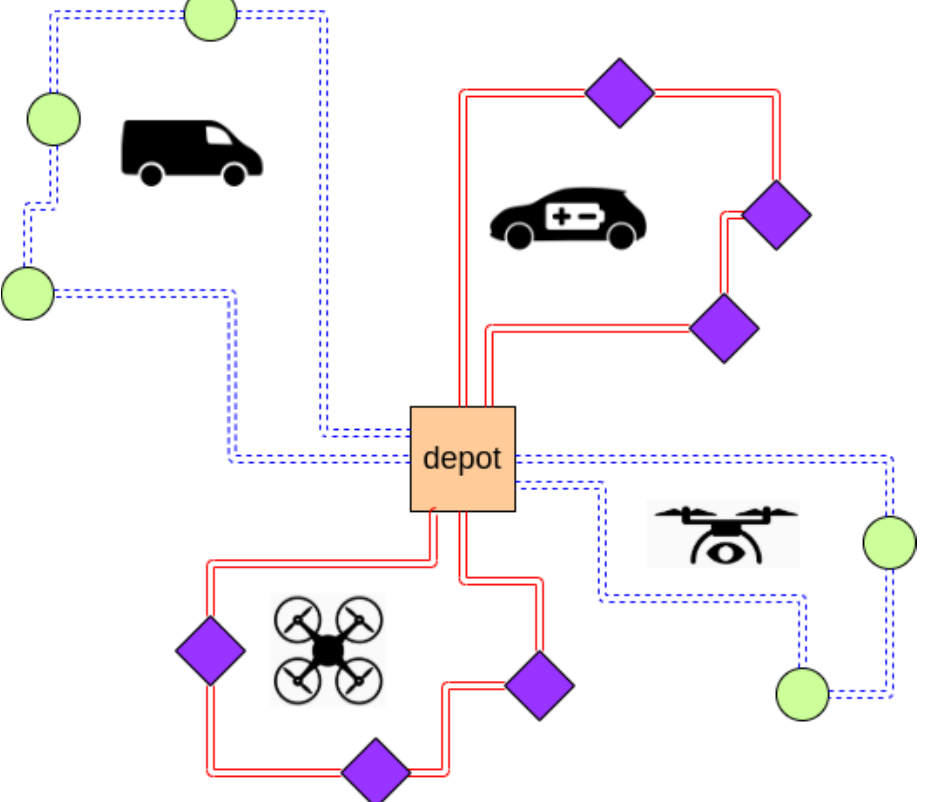
Figure 6. Generating last-mile delivery plans using hybrid fleet configurations with electric and diesel